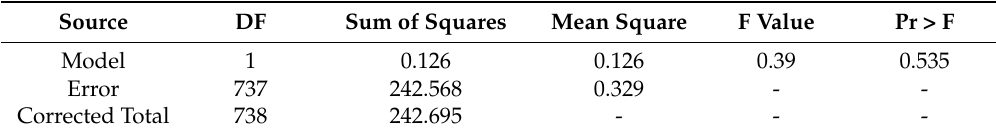
Table 14. Analysis of variance (ANOVA) table for leaf number.